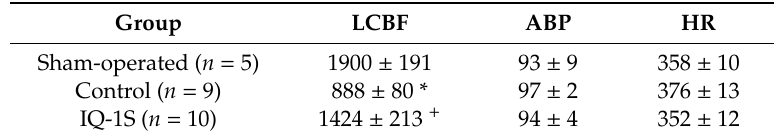
Table 3. The e ff ects of IQ-1S (50 mg / kg) on LCBF (BPU, a blood perfusion unit), mean arterial